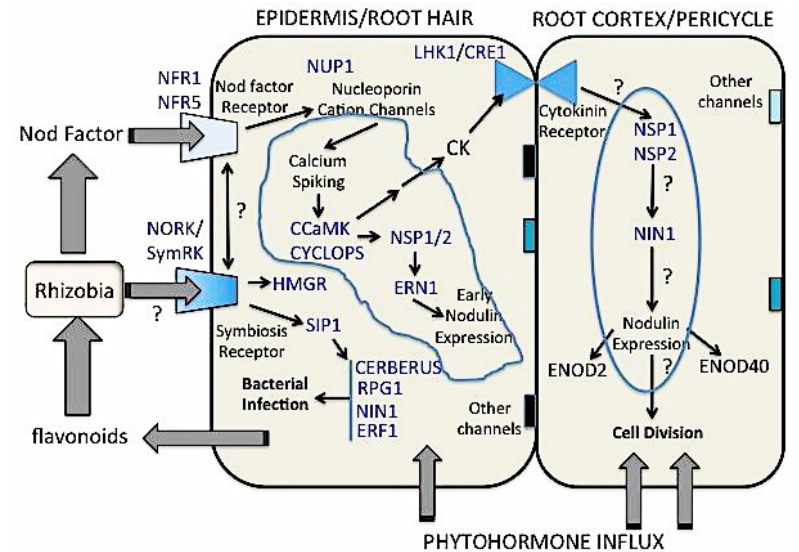
Figure 1. Early nodulation gene cascades in legumes. Flavonoids released by the plants are detected by compatible bacteria in the rhizosphere leading to production of Nod factors (NF), which are perceived by a dimer receptor made up of LysM type receptor kinases NFR1 and NFR5 at the root epidermis. This triggers the downstream gene cascade including those involved in nucleoporin, cation channels, calcium spiking, early nodulin expression and cytokinin signalling leading to cortical and pericycle cell divisions, and concomitant bacterial